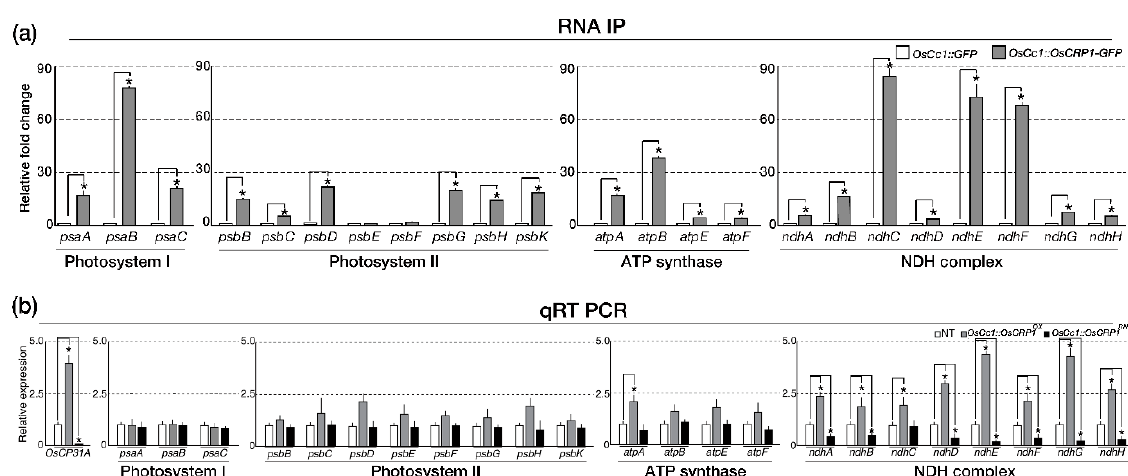
Figure 2. Identification of OsCRP1 target cpRNAs. The GFP-tagged transgenic rice plants were generated using the OsCc1::OsCRP1-GFP vector. Soluble protein and total RNA extractions and RNA-immunoprecipitation (RIP) assays were conducted with 2-week-old OsCc1::OsCRP1-GFP transgenic leaves. ( a ) Identification of OsCRP1 target chloroplast RNAs (cpRNAs) by RIP. cDNAs were synthesized using the immunoprecipitated RNAs and α -GFP antibodies, prior to quantitative RT-PCR. All the values were normalized based on total input RNA per sample, and bars represent the mean ± SD of four repeats. ( b ) Relative expression levels of cpRNAs in total RNA samples from OsCc1::OsCRP1 OX , non-transgenic (NT) and OsCc1::OsCRP1 RNAi plants. qRT-PCR with cDNA from NT and transgenic leaves was performed using 23 chloroplast gene-specific primer sets. All the values were normalized to the internal OsUbi1 control gene, and data bars represent the mean ± SD of two biological replicates, each of which had three technical replicates. Significant differences from the control are indicated by asterisks (Student’s t -test, * p <